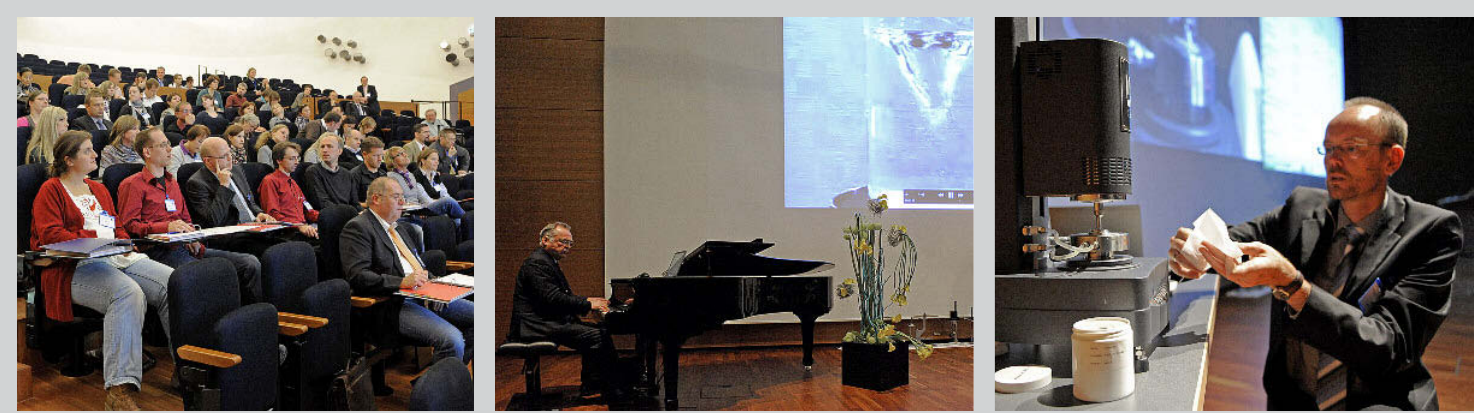
Figure 3 (left): The Auditorium. Figure 4 (middle): Prof. Gottfried Böttger. Figure 5 (right): Maik